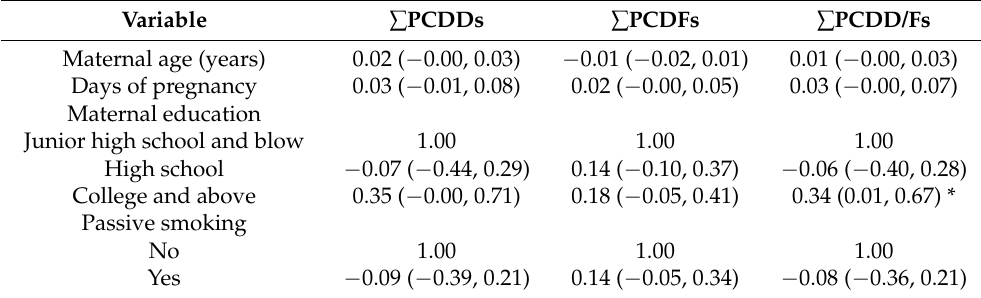
Table 3. Results of the multivariate linear regression model for the groups of ln-transformed concentrations in maternal serum ( n = 305).